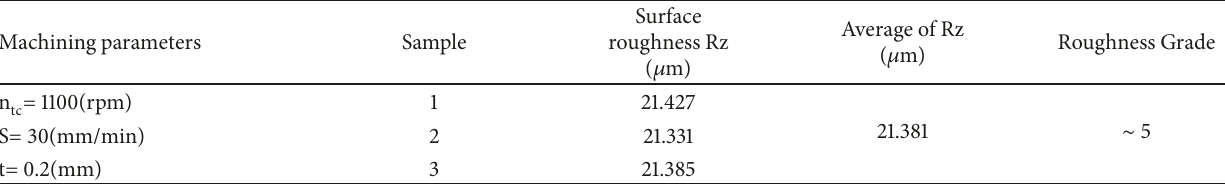
Table 8: Surface roughness results for samples 1, 2, and